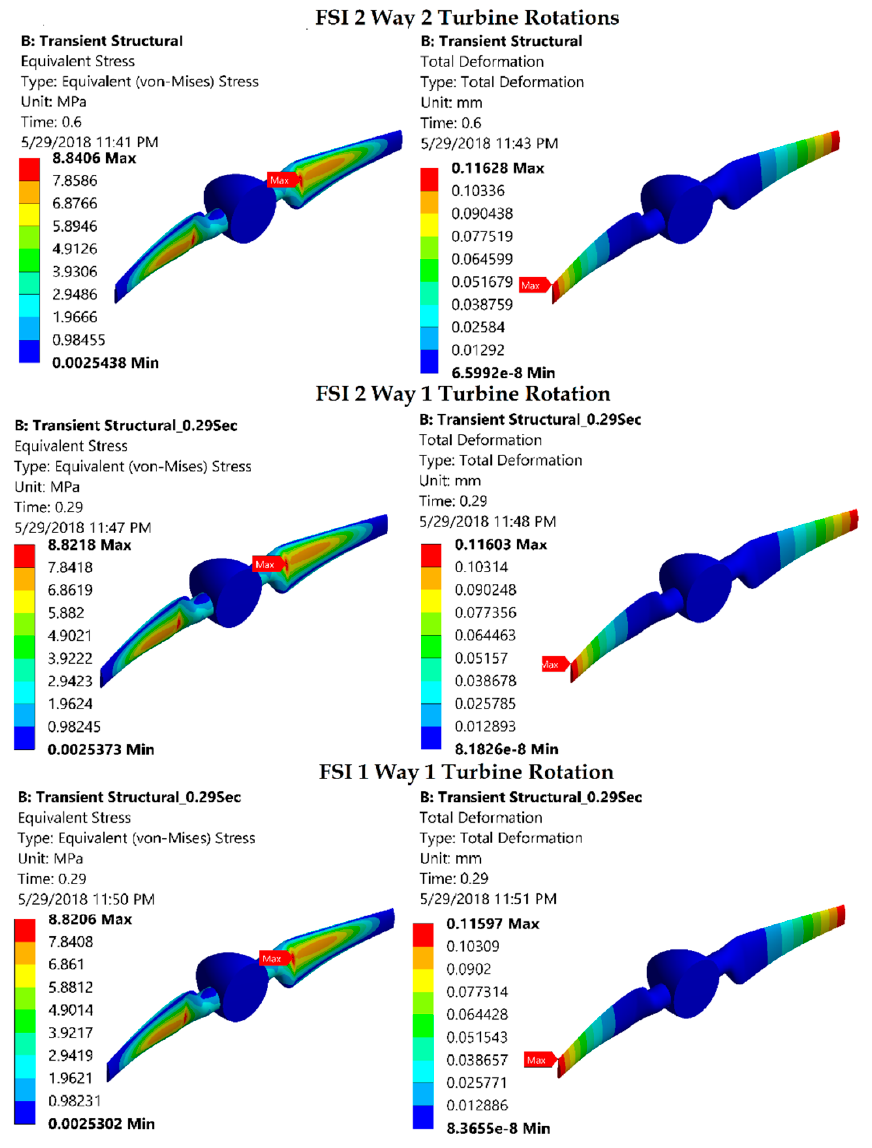
Figure 5. Contour plots of equivalent stress and total deformation on rotor at the last time step from the three FSI simulations.